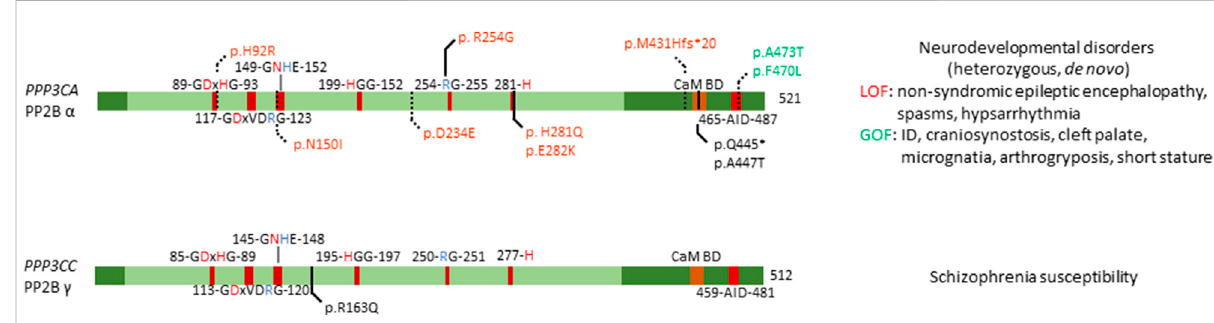
FIGURE 4 Overviewofcongenitaldisease-causingvariantsincalcineurin(PP2B,PP3)subunits.Overviewofvariantsinthecatalyticsubunitsofcalcineurin, with conserved residues annotated. Red amino acids denote metal binding, blue denote phosphate binding. CaM BD, Ca 2+ -calmodulin binding domain; AID, auto-inhibitory domain. Variants in green denote alleged or proven gain-of-function mutants, variants in red: loss-of-function mutants, variants in black: pathogenic mechanism unknown. Dotted lines near variants denote that functional or molecular data have been